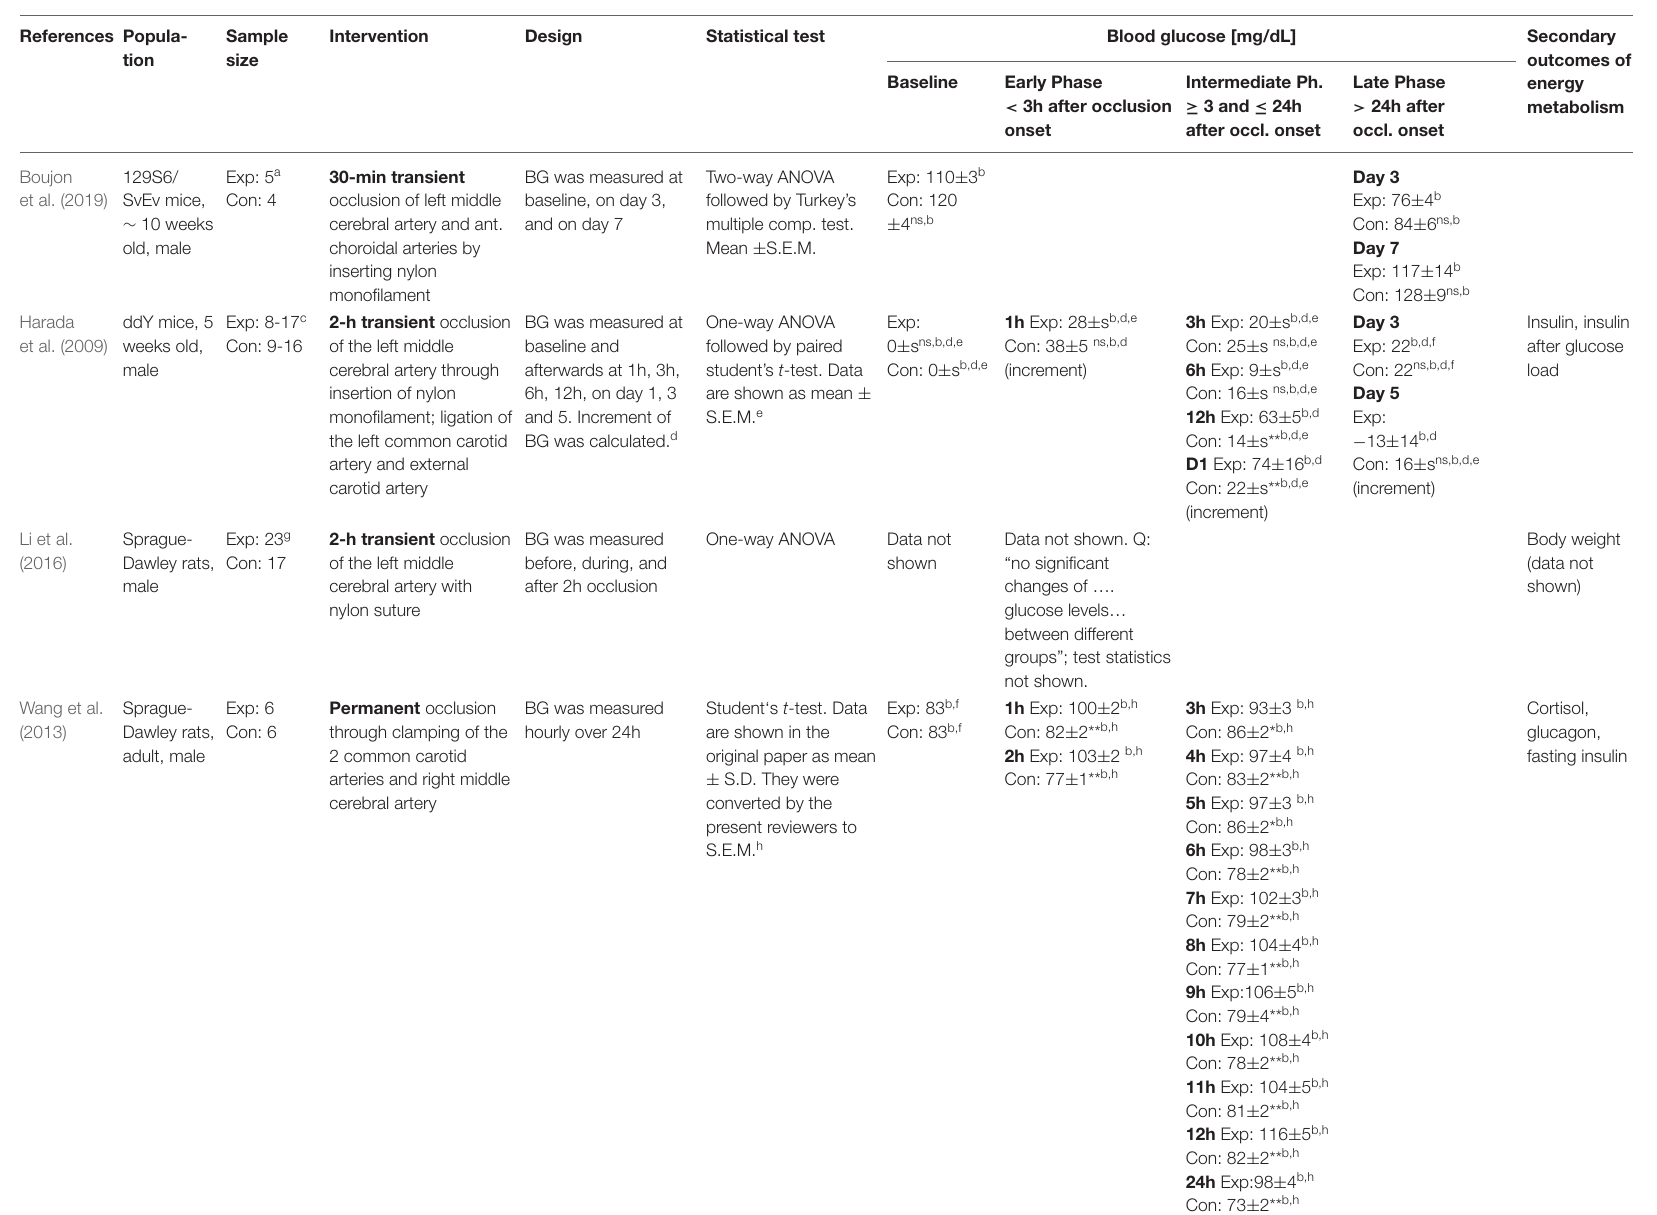
TABLE 1 | Characteristics and results of included